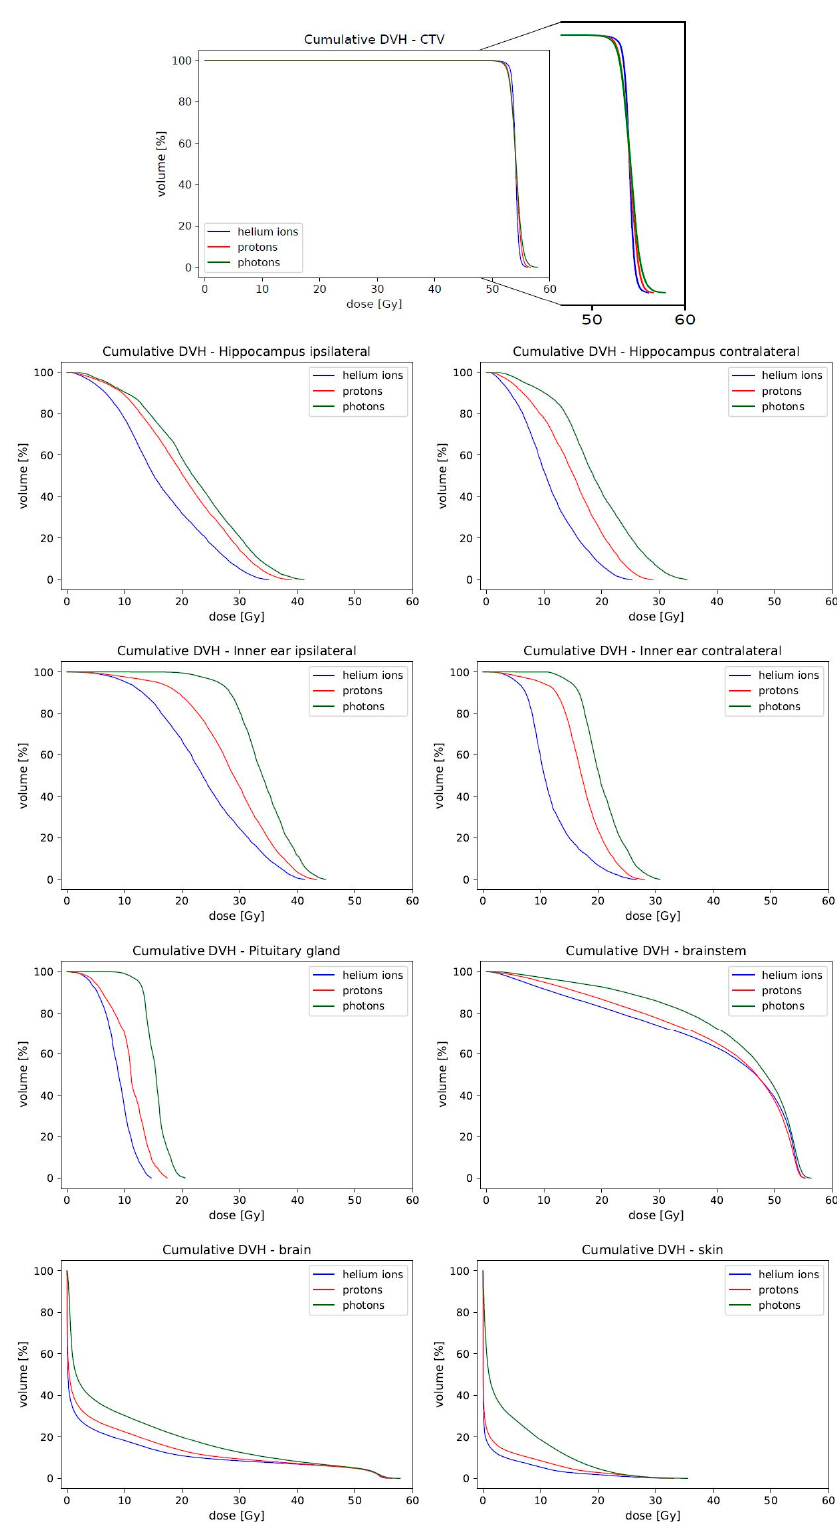
Figure 2. Cumulative dose–volume histograms (n = 15). Shown are the average sum doses of CTV and all OAR for helium ions (blue), protons (red) and photons (green). Target coverage is comparable. The dose–volume curve of helium ions is slightly steeper compared to the other treatment modalities. The dosimetric advantage of helium ions can be seen for all OAR.